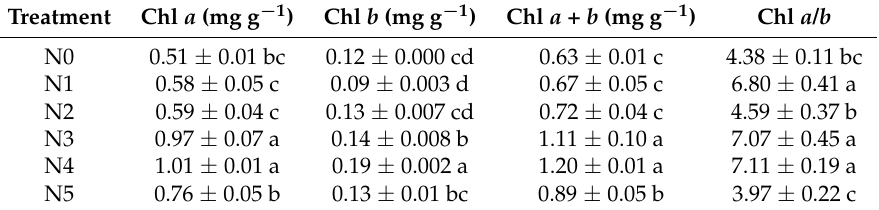
Table 2. Effects of different N supply rates on the mean ( ± SE) values of foliar chlorophyll concentration.